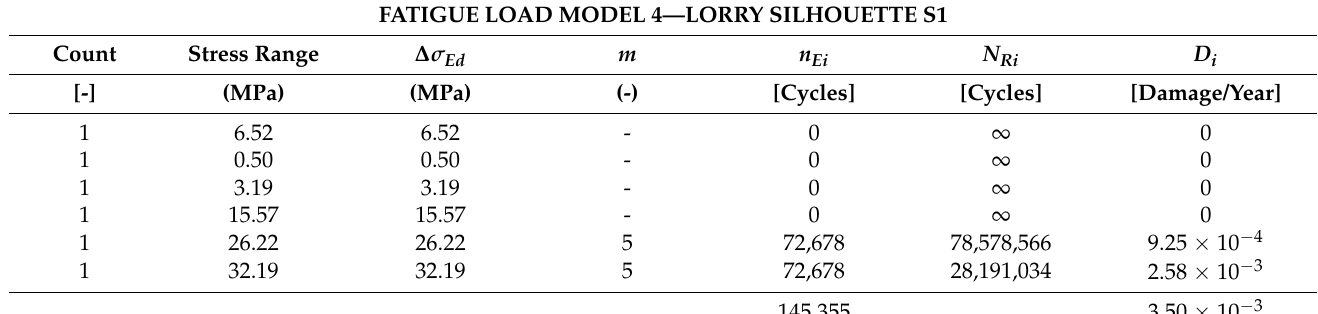
Table 4. Distinction of detail assessment: Rib-to-Plate—FLM4